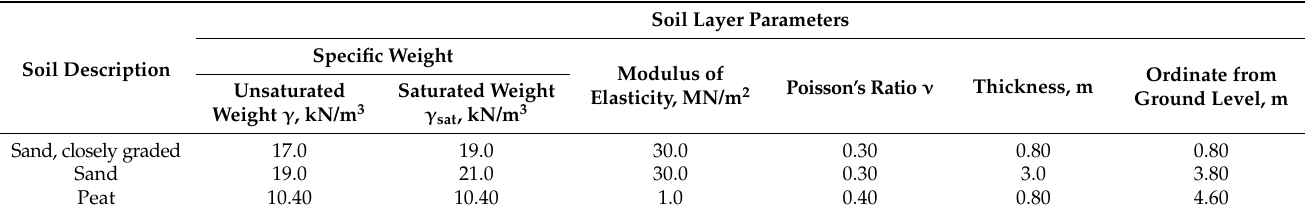
Table 5. Soil materials of soil type